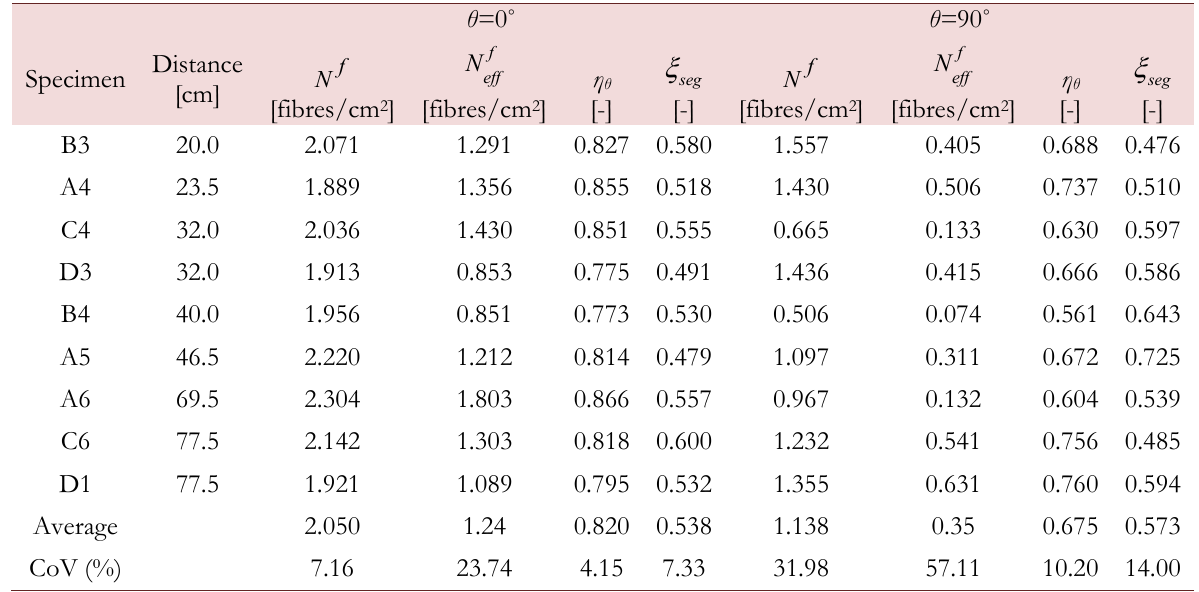
Table 2: Fibre distribution parameters.